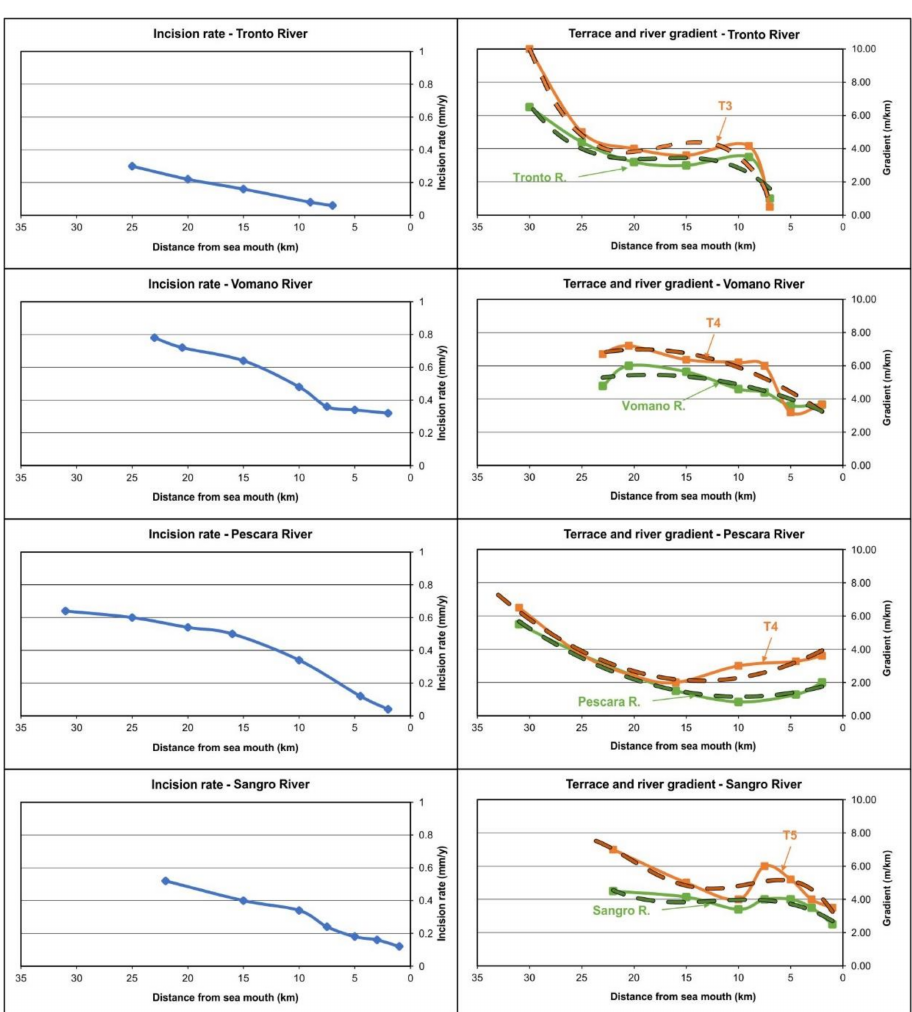
Figure 10. On the left column, the estimated incision rate of the analyzed river basins. On the right column, the comparison between the terrace and the river gradient. Note: the solid line represents the present-day gradient; the dashed line indicates the best fitting curve (orange curves represent the analyzed fluvial terrace bottom; green curves show the present-day valley bottom